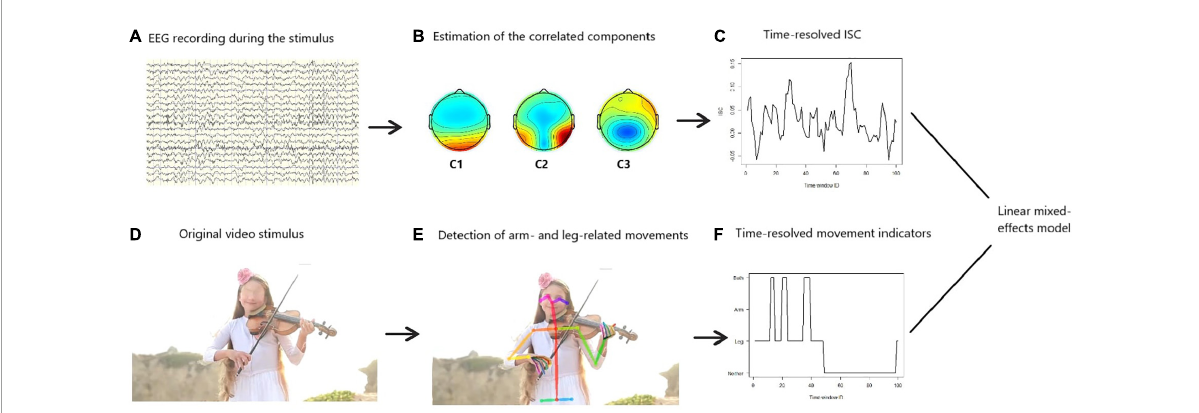
FIGURE1 Schematic representation of the data analysis. Based on the preprocessed electroencephalography (EEG) signals (A) , we extracted components that are maximally correlated among participants (B) . Using these components, we projected the EEG data to the so-called components’ space and measured the intersubject correlation (ISC). We did this in a time-resolved fashion, i.e., repetitively for sliding time windows of 1.5 s size and 80% overlap. This revealed how the ISC changed across time (C) . Furthermore, we applied a machine-learning algorithm to the original video stimulus (D) in order to detect scenes in the videos where arm- or leg-related movements occur (E) . We did this in a time-resolved fashion, i.e., repetitively for sliding time windows of 1.5 s size and 80% overlap (F) . Therefore, the time series displayed on panels (C,F) were perfectly temporarily aligned. Then, we estimated a linear mixed-effects model to predict the ISC based on the time-resolved movement indicators, while participants’ age was included as a covariate.